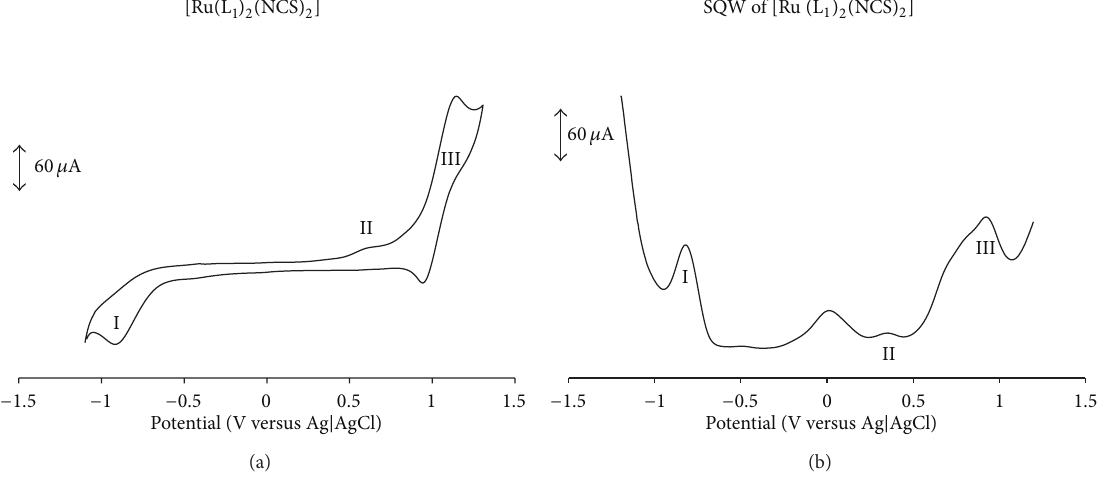
Figure 8: Cyclic and square wave voltammograms (a and b) for [Ru(L 2 ) 2 (NCS) 2 ] complex at 1 × 10 −3 M in freshly distilled DMF containing 0.1M TBABF 4 supporting electrolyte. Step potential is 5 mV, amplitude is 60mV versus Ag | AgCl, and frequency is 10Hz. Scan rate is 100m Vs −1 versus Ag |